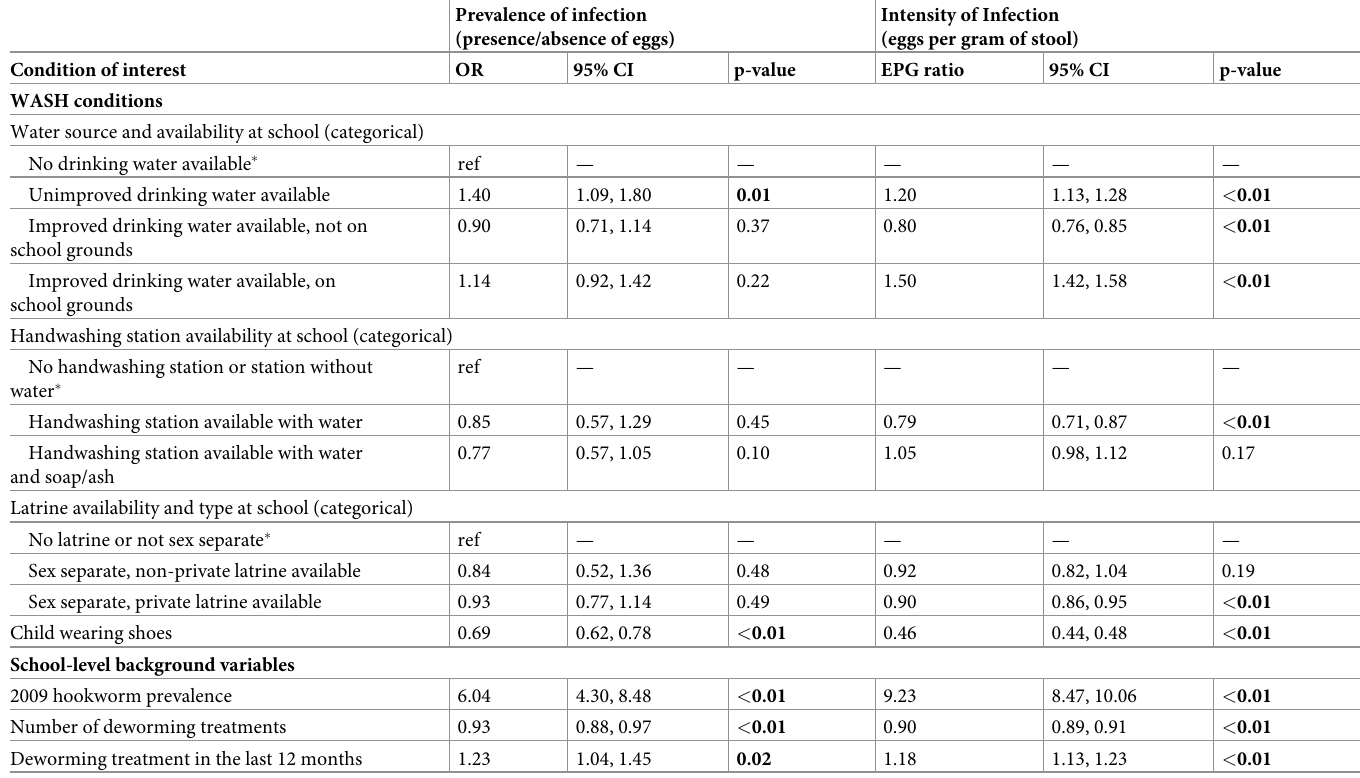
Table 4. Multivariable associations between WASH conditions and prevalence/intensity of hookworm